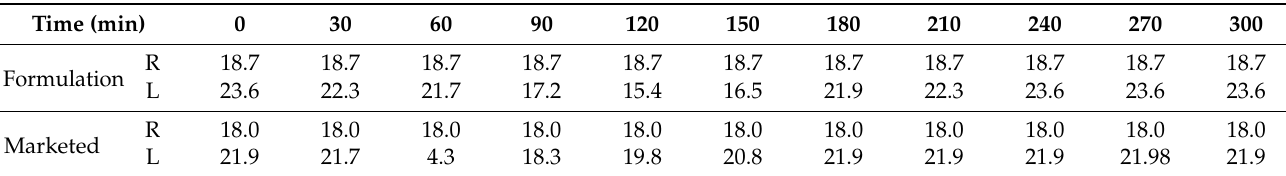
Table 6. Intraocular pressure (IOP mm Hg).